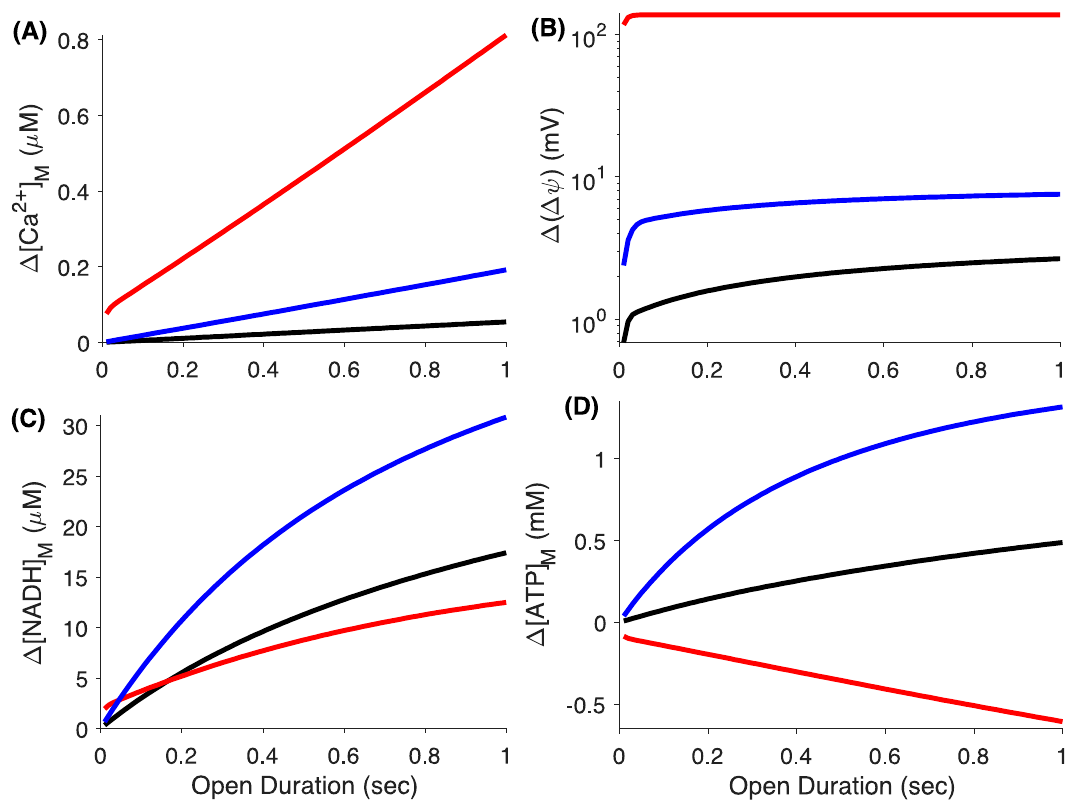
Figure 5. Relative changes in mitochondrial variables in response to the opening of a single IP 3 R channel at the single mitochondrion level. A single IP 3 R residing in the ER membrane is allowed to open for a given duration ( x -axes) starting at 100 s and the optimal changes with respect to the resting values of di ff erent mitochondrial variables are recorded (see Figure S6) and shown along y -axes. The change in [Ca 2 + ] M ( A ), ∆ ψ ( B ), [NADH] M ( C ), and [ATP] M ( D ). A 24 nm wide microdomain is considered in these simulations.